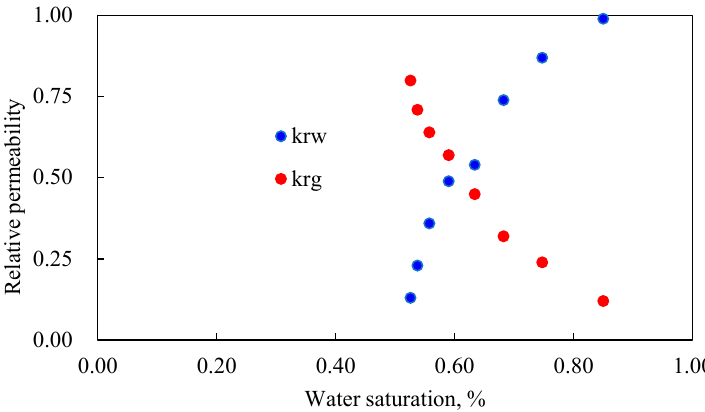
Figure 5. Relative permeability plot.